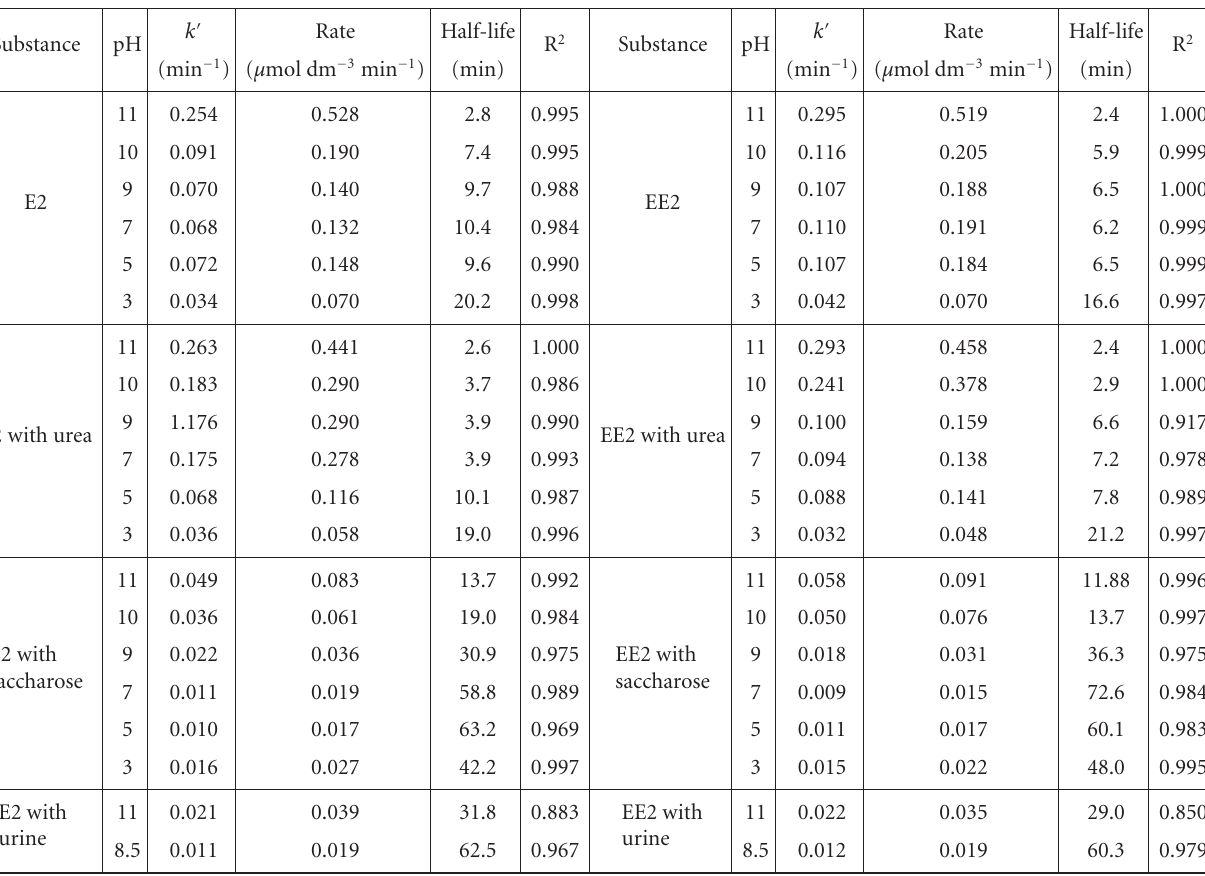
Table 1: Kinetic parameter value for PCO of SEs with and without copollutants.